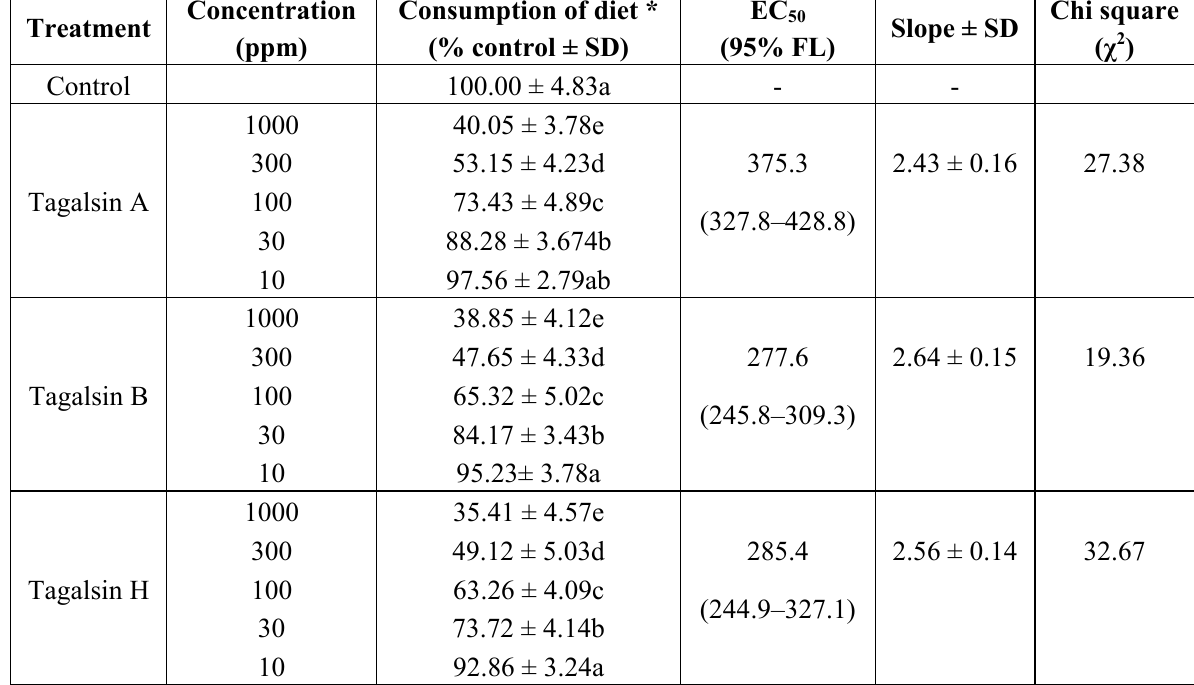
Table 1. Feeding deterrent activity of the pure compounds isolated from C. tagal stems and twigs against T. castaneum